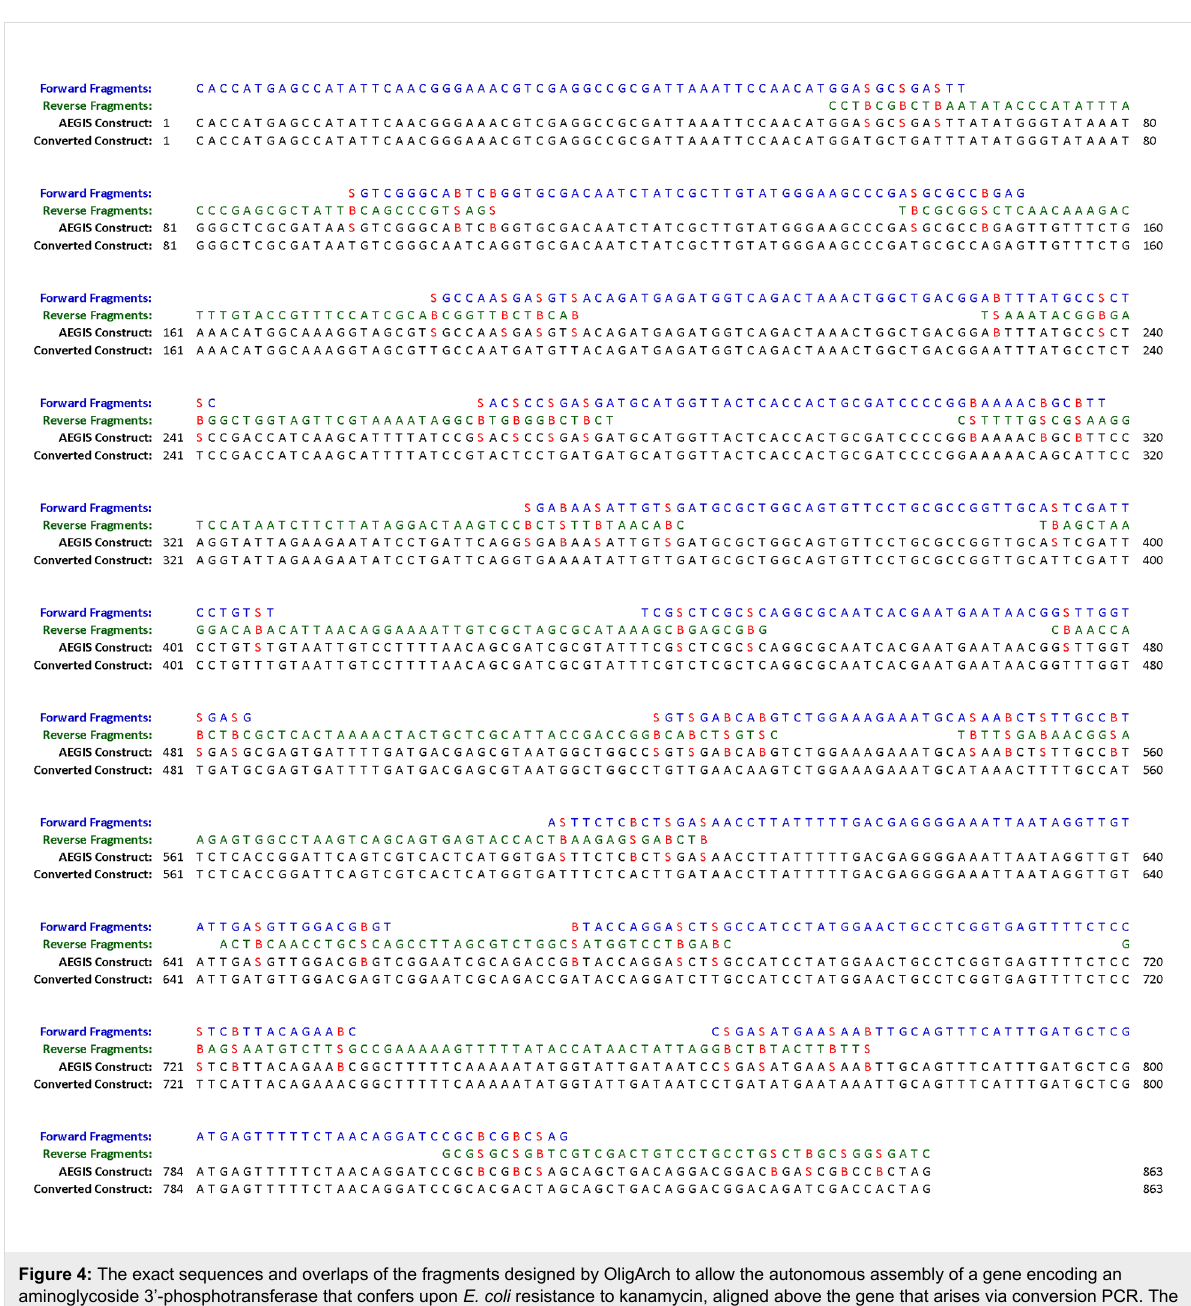
no more than a dozen or so fragments [22], although circa three dozen have been assembled inside of yeast cells